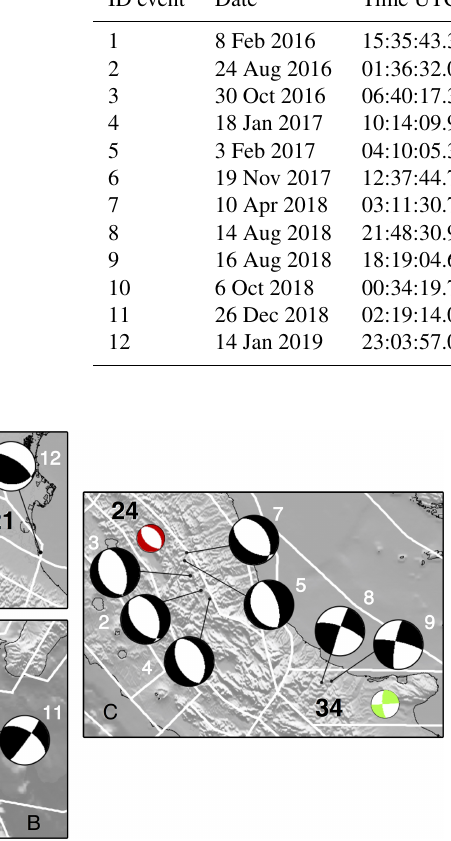
Table 4. List of earthquakes occurring after 2015 used in the comparison with the results of this study and mapped in Fig. 7. ID event Date Time UTC